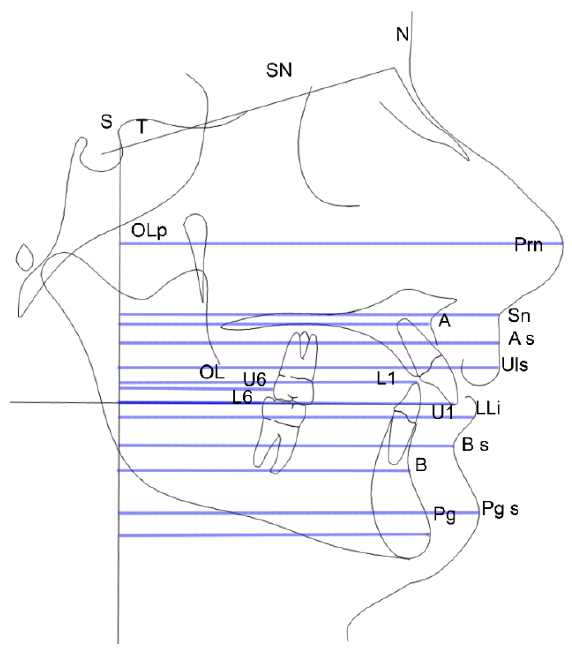
Figure 3. Linear measuring procedure.